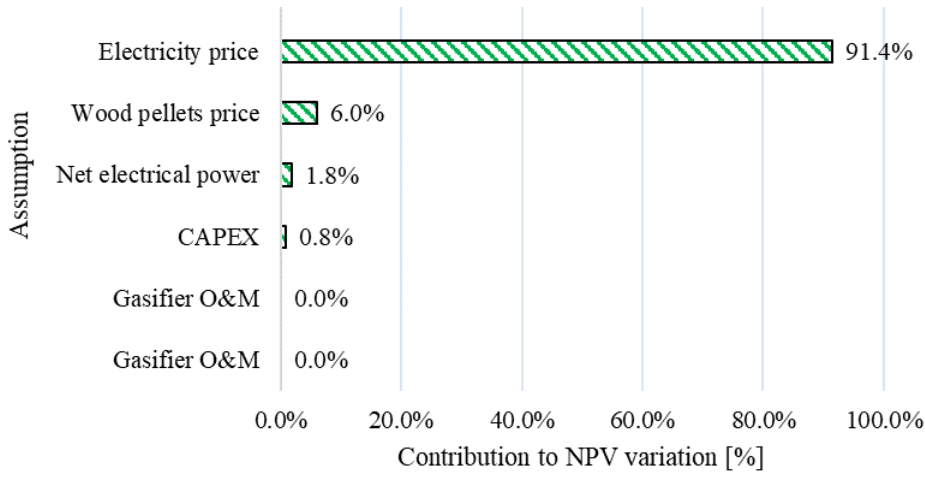
Figure 14. Assumptions scatter plot for the Monte Carlo simulation considering the NPV as a target in the gas microturbine and downdraft gasifier-based generation system.